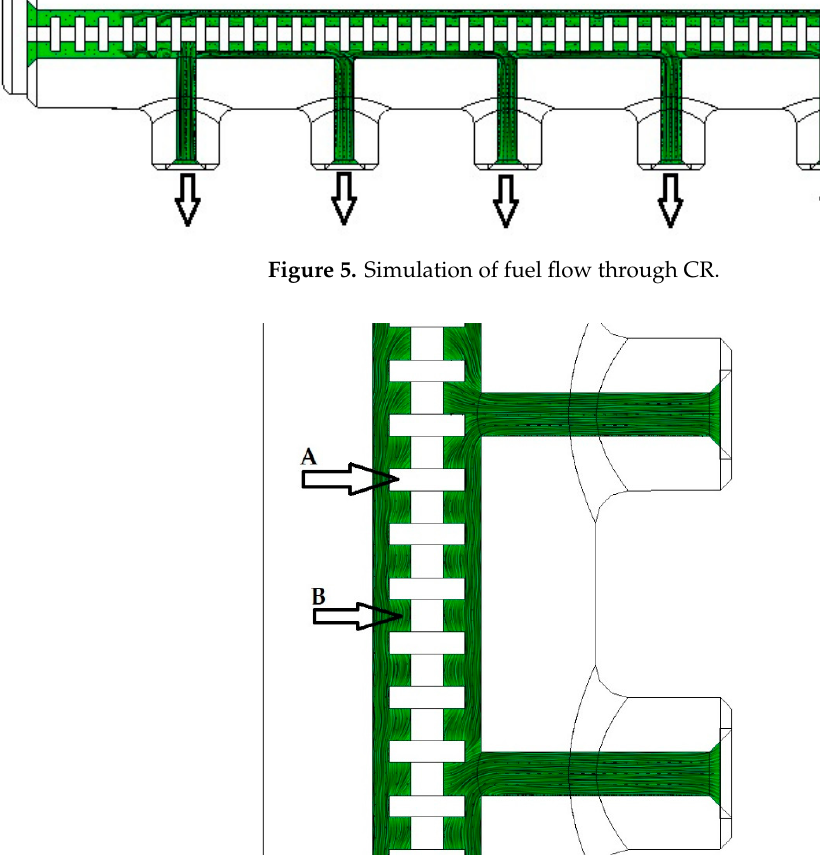
Figure 6. Common rail with catalyst. ( A ) Catalyst reactor; ( B ) fuel flowing through the reactor.